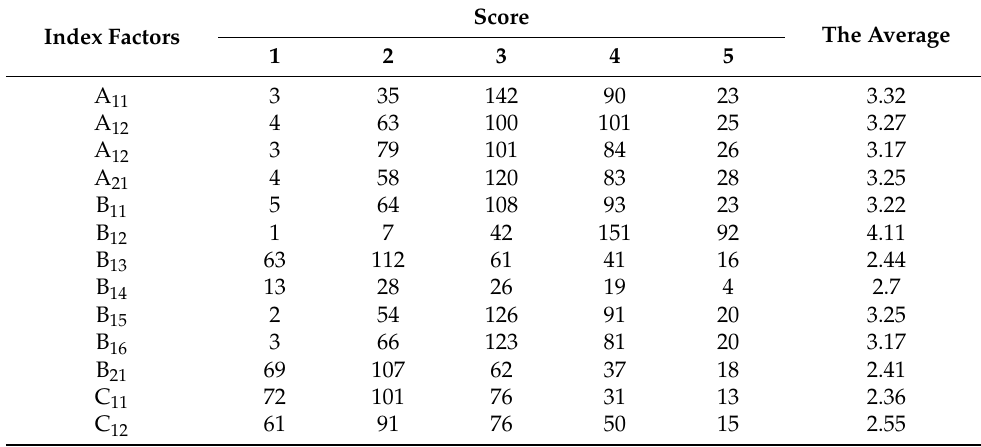
Table A2. Data summary form of statistical table of questionnaire